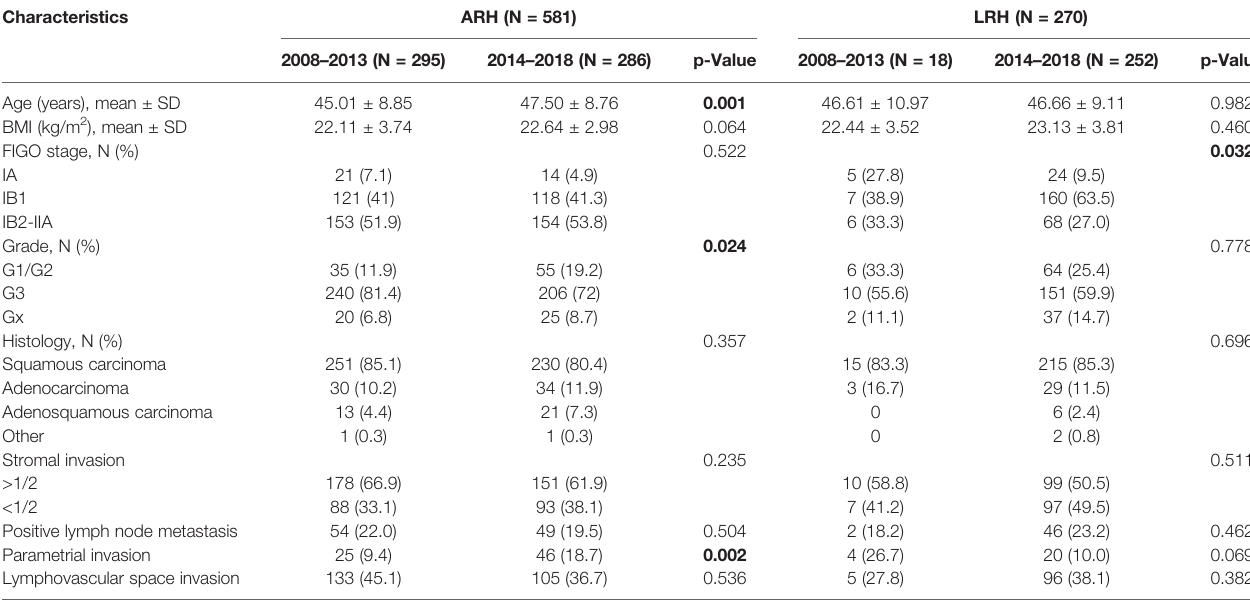
TABLE 1 | Baseline characteristics in ARH and LRH groups. Characteristics